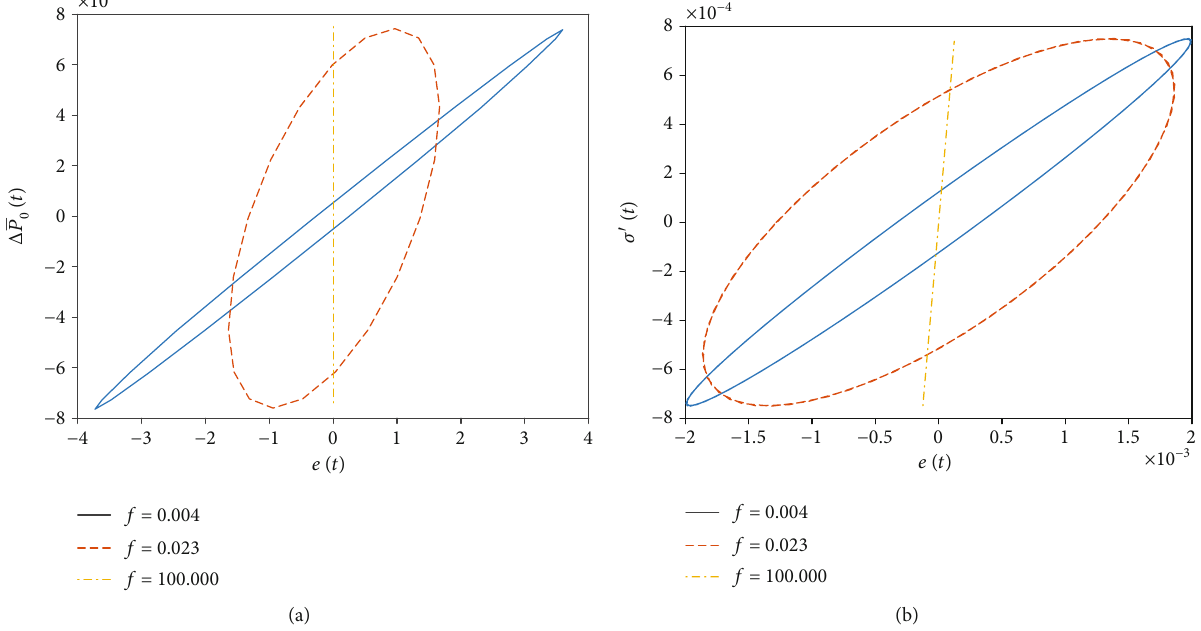
Figure 11: In fl uence of frequency, f on mechanical-hysteresis behavior. (a) Mechanical hysteresis established by the PCD equation at j = 0 : 2600 and ϵ = 0 : 1750 and (b) mechanical hysteresis established by the SLS model at conditions σ conditions j (cid:1) ρ 0 and τ = 1 : 6670 where e ð t Þ ( x -axis) is the strain response at time t whereas Δ established by the PCD equation and SLS model,